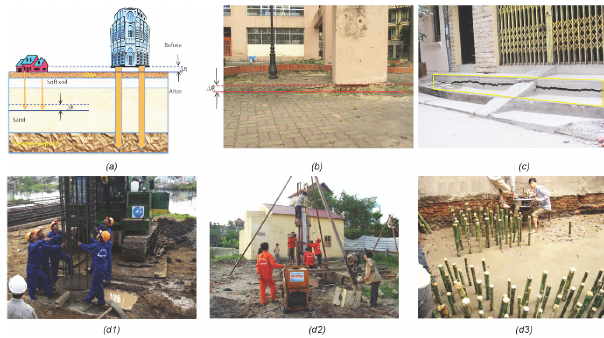
Fig. 9. (a) Model of subsidence process. Example of subsidence damages in (b) Dinh Cong residential zone at Hoang Mai sub- sidence area. (c) Van Quan residential zone at Ha Dong subsi- dence area. For location of investigation points, refer to Fig. 3. Several types of foundation are used in the study area: (d1) auger- cast piles, (d2) concrete pillars, (d3) bamboo piles (after: http: